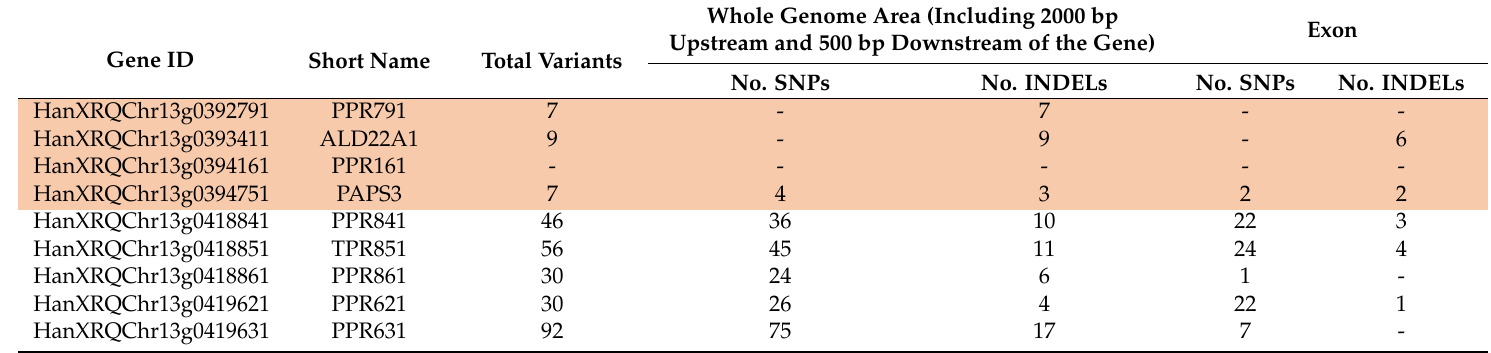
Table 3. Overview of the SNPs and INDELs detected in the candidate genes for Rf1 detected in an association panel of 27 maintainer lines and 32 restorer lines (Minor allele frequency >